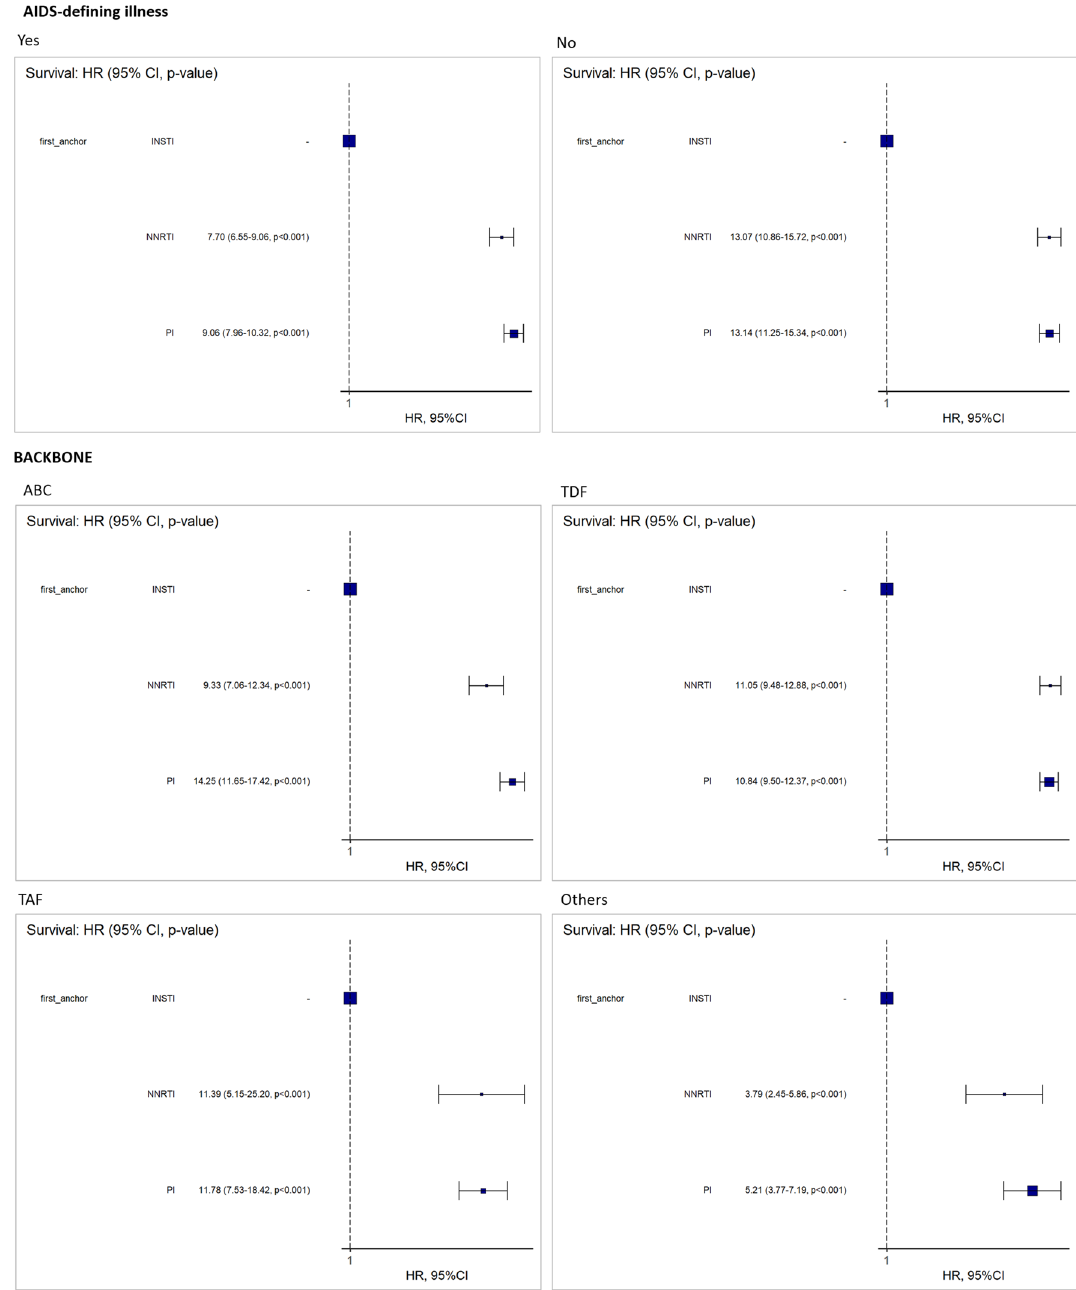
Figure 4. Hazard ratio for switching of each anchor drug class stratified by AIDS-defining illness and backbone drugs. NNRTI Non-nucleoside reverse transcriptase inhibitor, PI Protease inhibitor, INSTI Integrase strand transfer inhibitor, TAF Tenofovir alafenamide, TDF Tenofovir disoproxil fumarate, ABC Abacavir, CI Confidence interval. Variables, including the type of backbone, anchor drug class, AIDS-defining illness, and two interaction terms (between anchor drug class and AIDS-defining illness and between anchor drug class and type of backbone) were selected in the Cox regression analysis. Subsequently, the HR was calculated for anchor drug class stratified by each interaction term (AIDS-defining illness and type of backbone). The filled circles indicate the hazard ratio, and the horizontal lines indicate the 95%